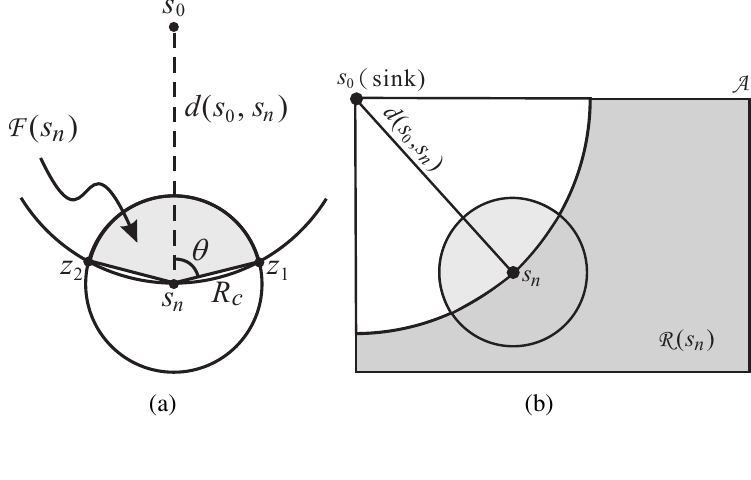
) . (b) The relaying zone of s , F ( s n n